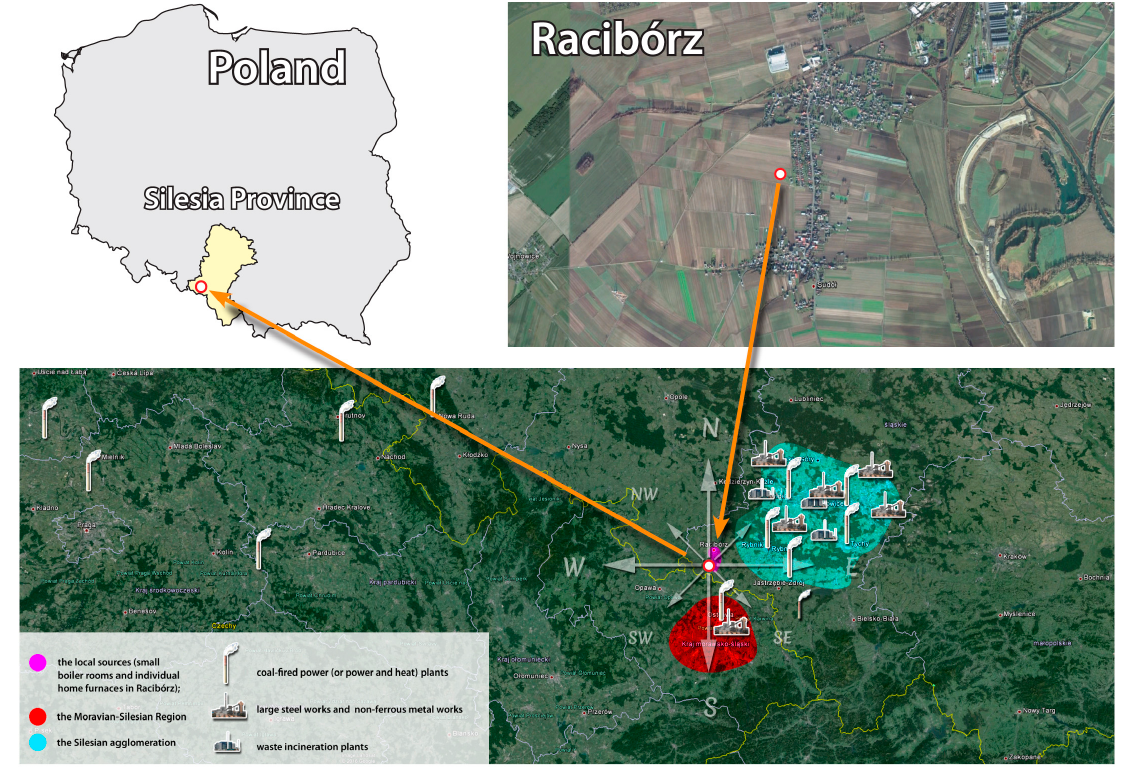
Figure 1. Sampling point location.